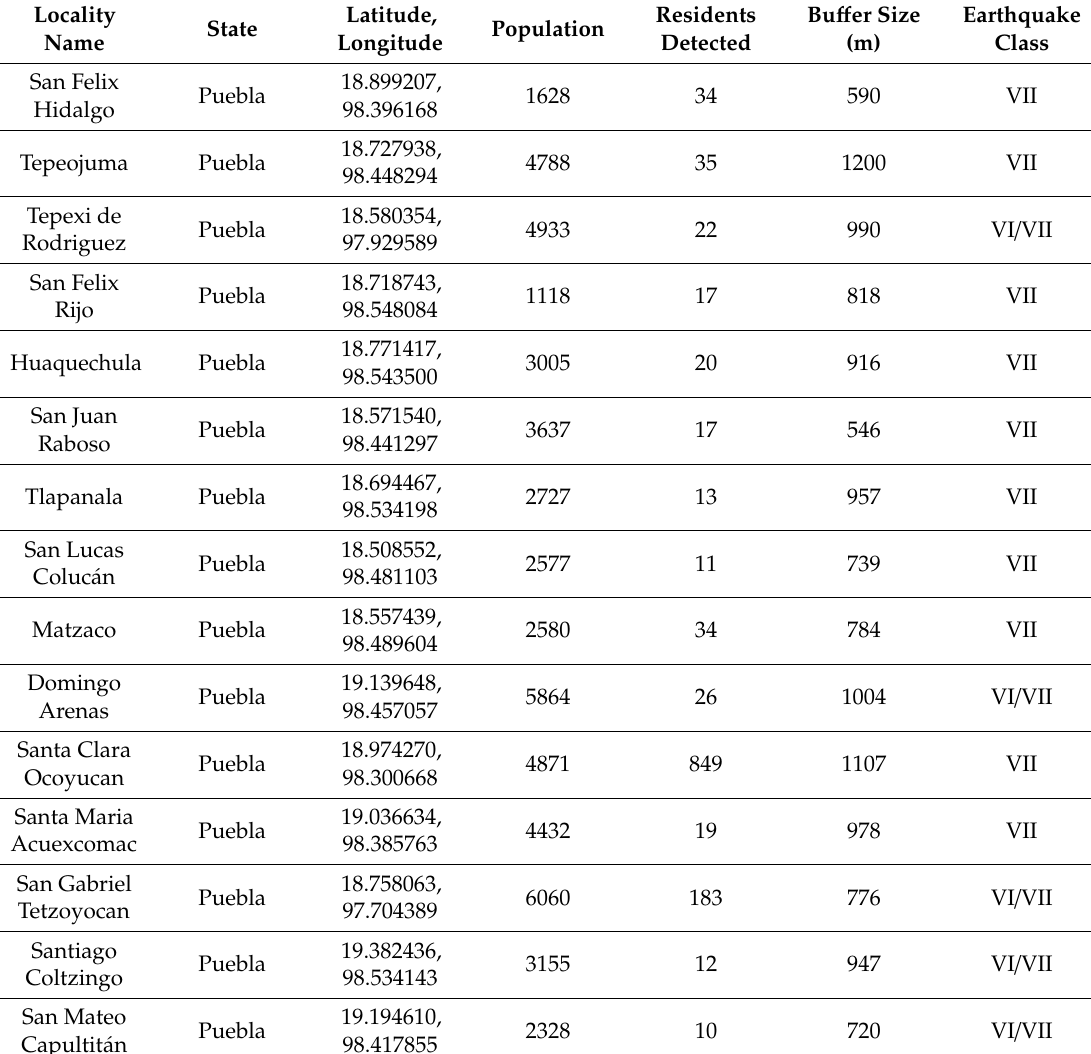
Table A3. Fifteen experimental localities were used in the final analysis all from earthquake class areas of VI / VII or higher. In processing, an additional 610m was added to this bu ff er radius to account for privacy data screening by the data